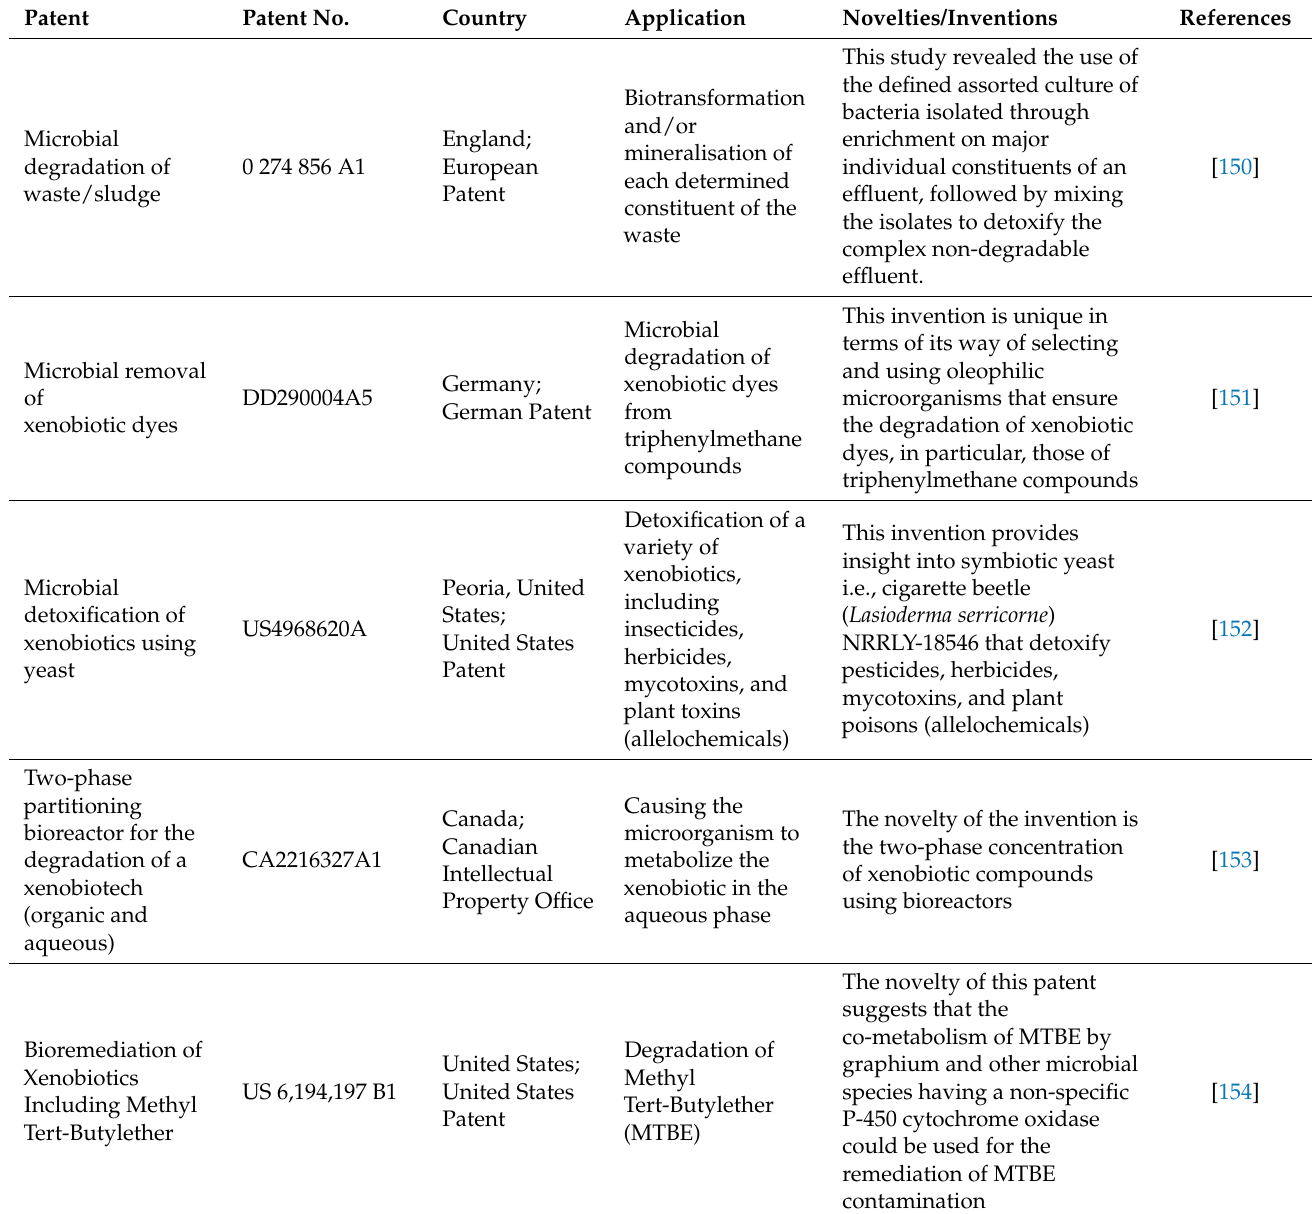
Table 5. Various patents and their properties used in the field of